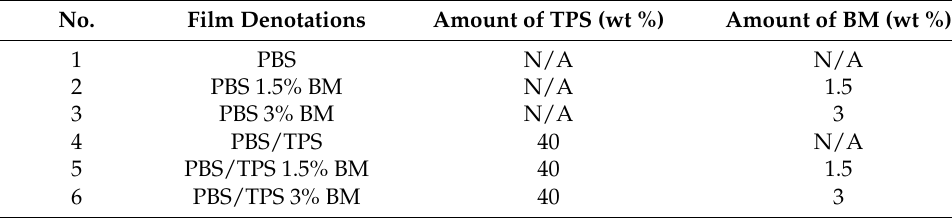
Table 1. Denotations and formulations of produced